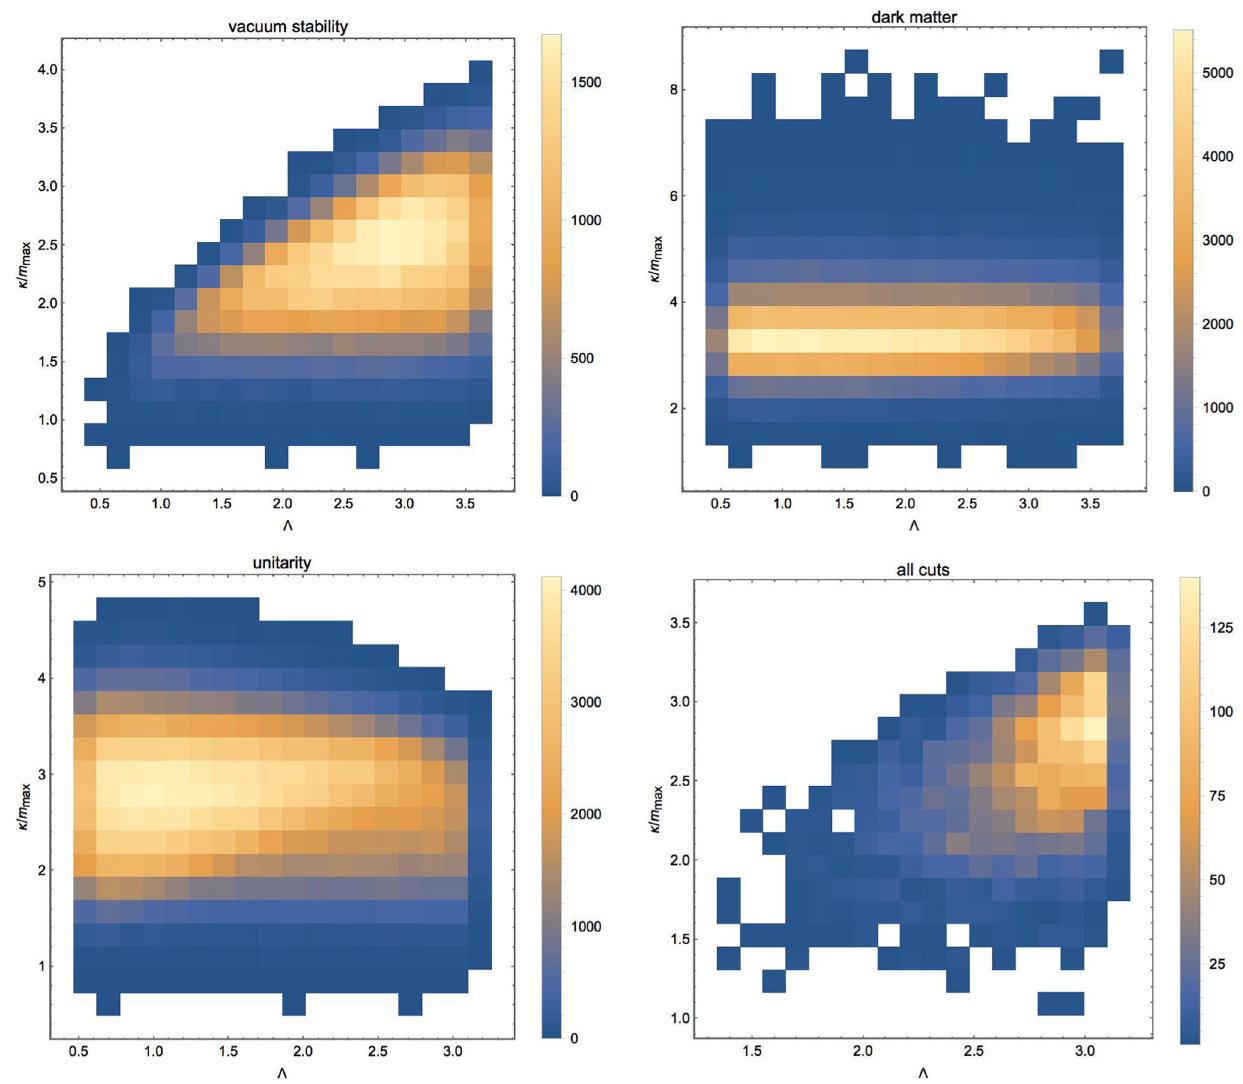
Fig. 4 Distribution of κ over the biggest mass (from m S and m O ) against (cid:8) . Top left: valid points after the vacuum stability cut. Top right: same after dark matter cut. Bottom left: same after unitarity cuts. Bottom right: same after all cuts. For values above ∼ 2, one observes